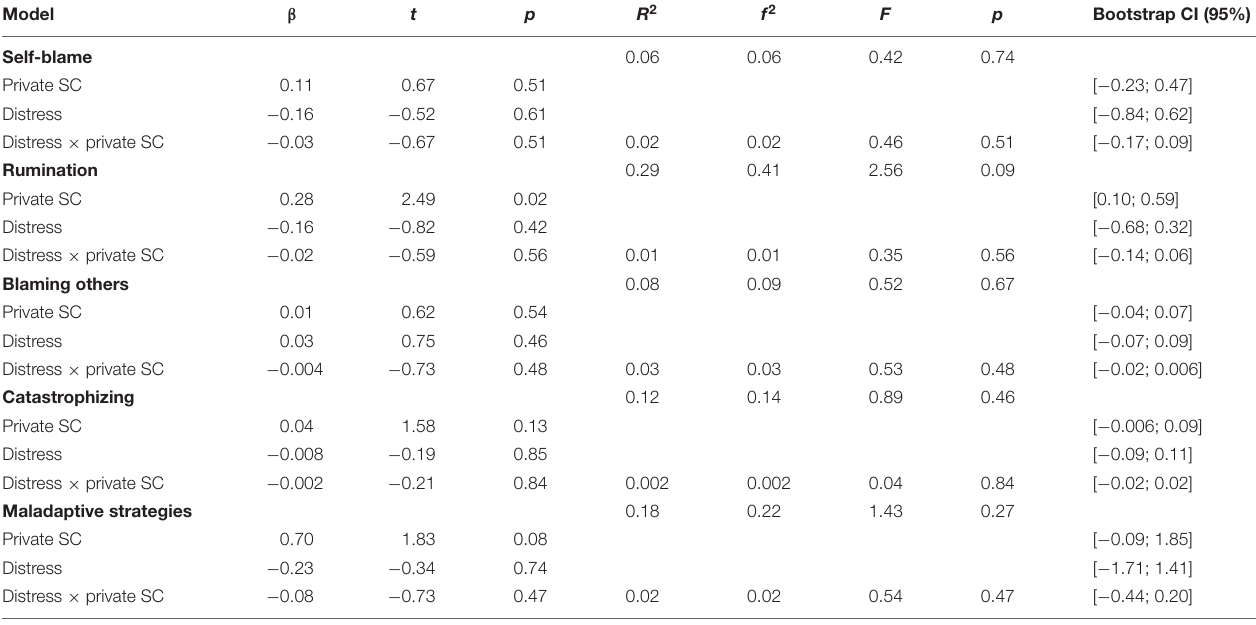
TABLE 7 | Multiple regression analyses predicting maladaptive emotion regulation strategies as a function of private SC, distress and their interaction in the control group. Model